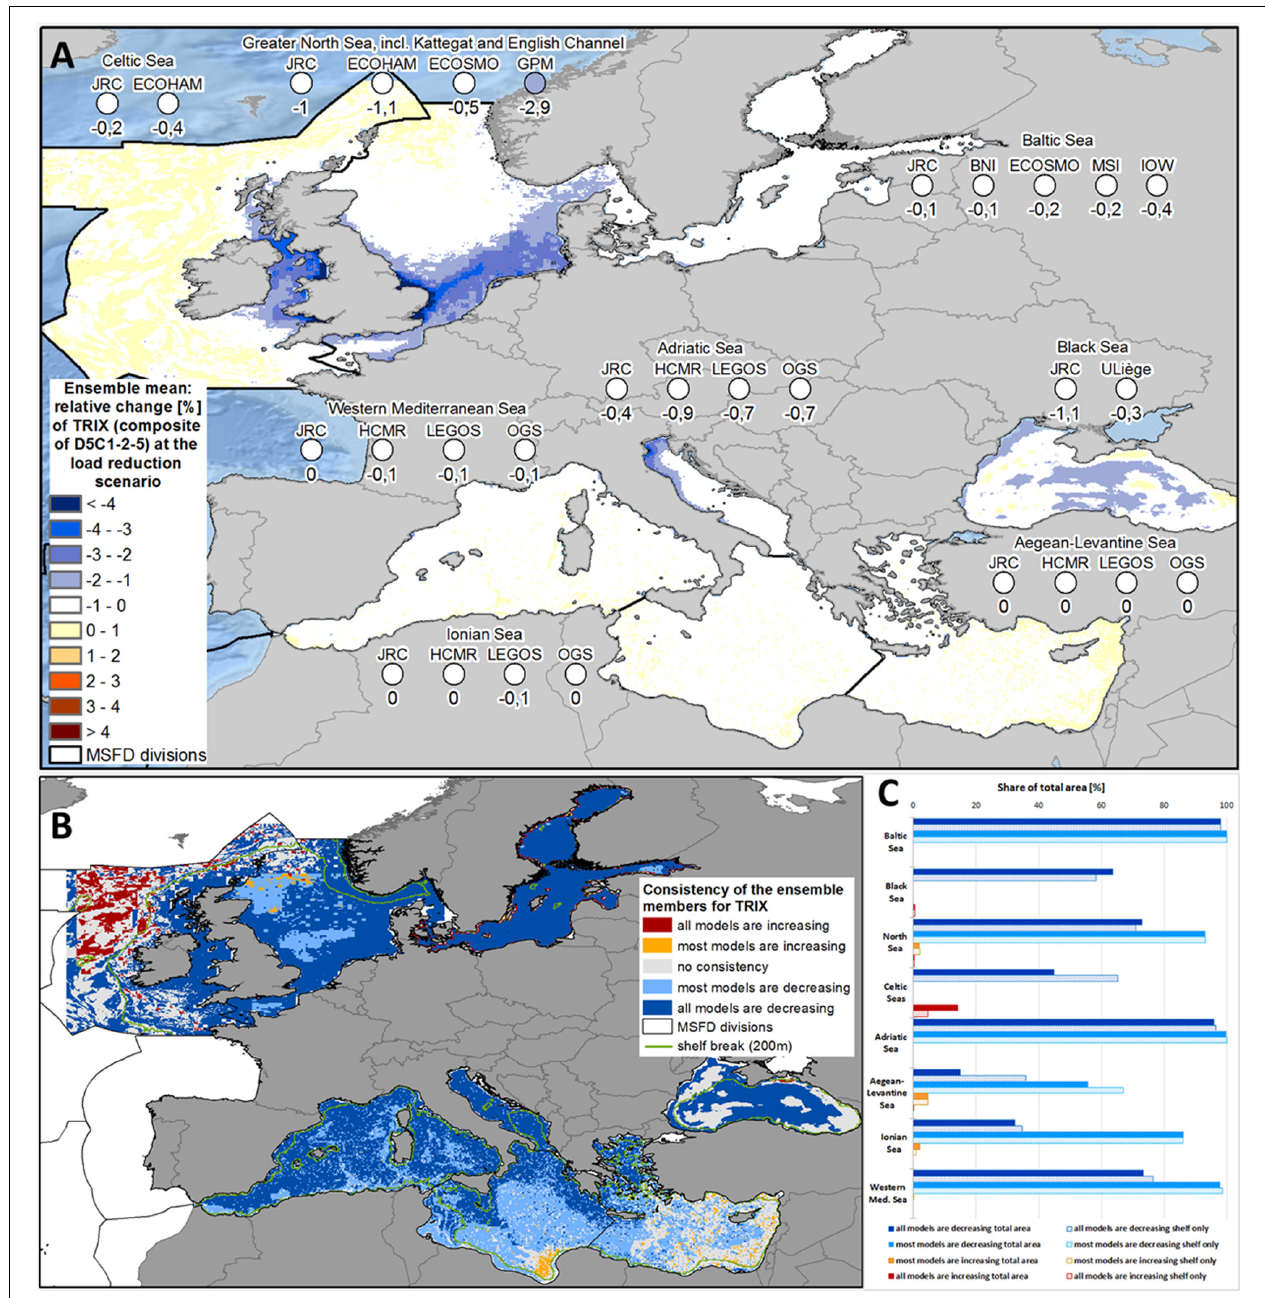
FIGURE 8 | (A) Ensemble means and model-specific relative change at load reduction scenario (compared to reference scenario) for the MSFD regions of the Trophic Index TRIX. (B) Consistency map showing, if all or at least most models have the same trend of the relative change at load reduction scenario (compared to reference scenario) with respect to the Trophic Index TRIX. (C) Share of the total area (bold bars) and of the shelf region (dotted bar), where all or most models show consistent changes with respect to the Trophic Index